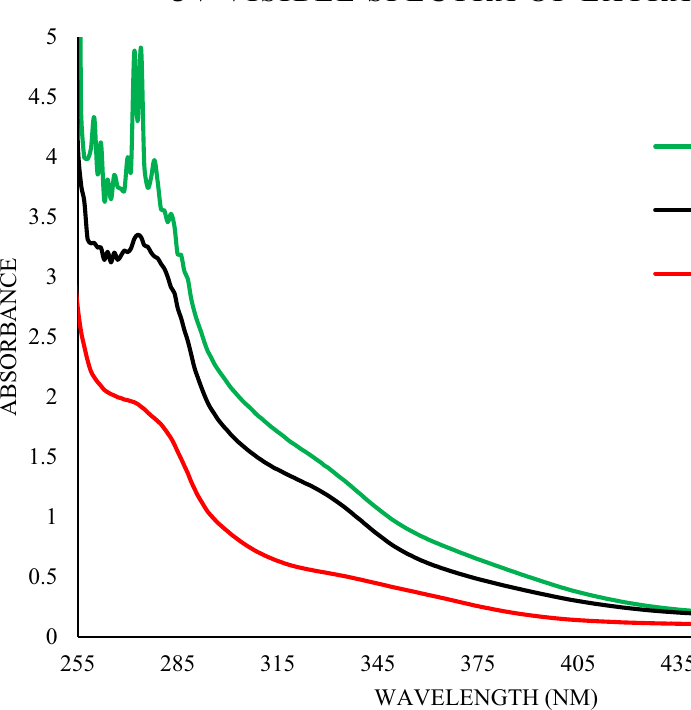
Fig. 3 Ultraviolet–visible spectra of Acacia rigidula’s